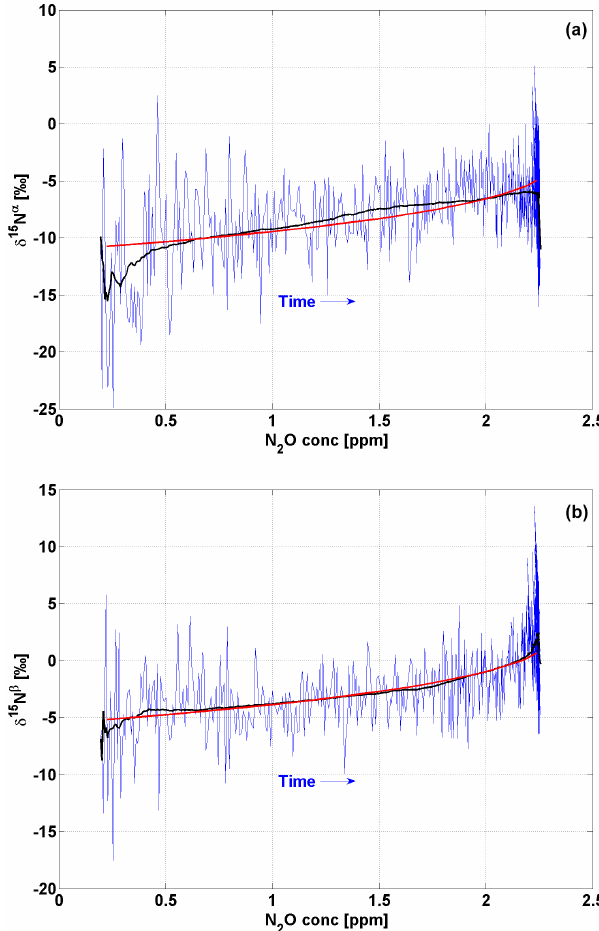
Figure 4. (a) SP as a function of N 2 O concentration as produced by P. chlororaphis . High-resolution CRDS data (blue line) and 5min running average (black line). The blue arrow indicates the direction of time during production of N 2 O. (b) SP as a function of N 2 O concentration produced by P. fluorescens . High-resolution CRDS data (blue and green line) and 5min running average (black line). The blue arrow indicates the direction of time during production of N 2 O whereas the green arrow indicates the direction of time during reduction of N 2 O.